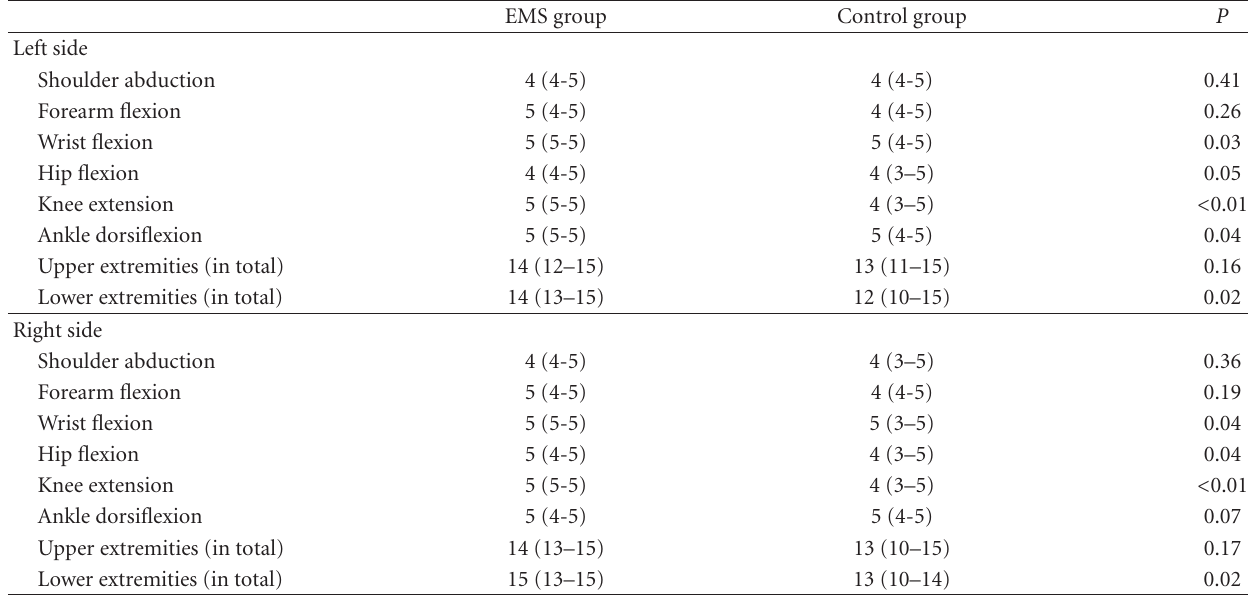
Table 2: MRC scores of all the upper and lower extremities’ movements (median (25th–75th percentiles)). P values refer to between-group comparisons for each